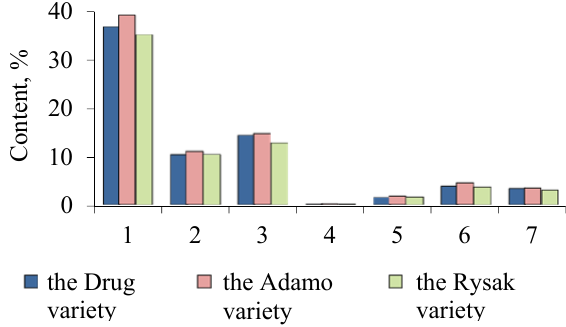
Fig. 3. Carbohydrate complex of the samples of oat grains: (1) starch, (2) fiber, (3) hemicellulose, (4) monosaccharides, (5) disaccharides, (6) β-glucan, (7)